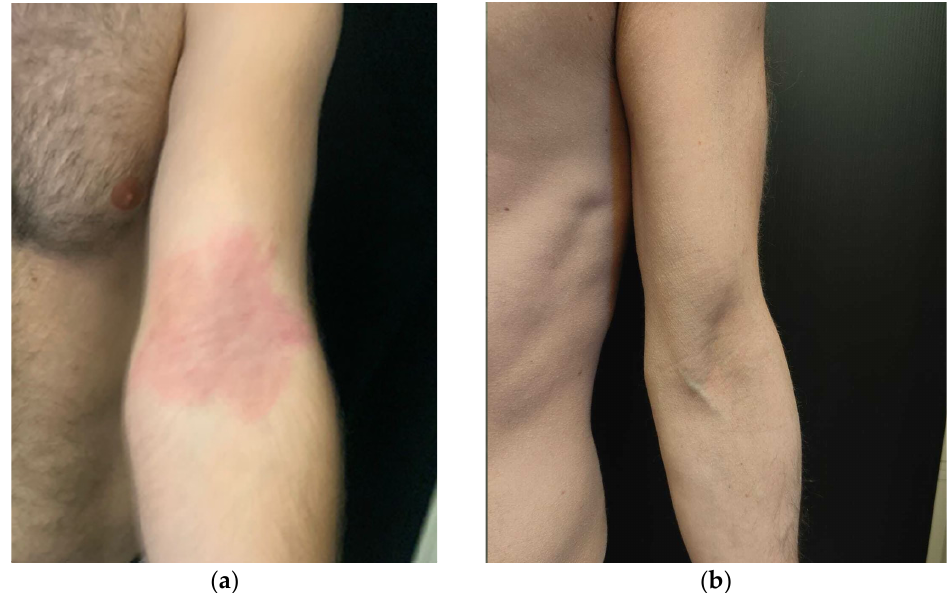
Figure 1. Atopic dermatitis. Clinical examination at the time of presentation, showing severe flexural involvement with erythema, papulation, and lichenification ( a ); then, after one month of therapy, the upadacitinib treatment’s induction of clear skin can be seen ( b ).